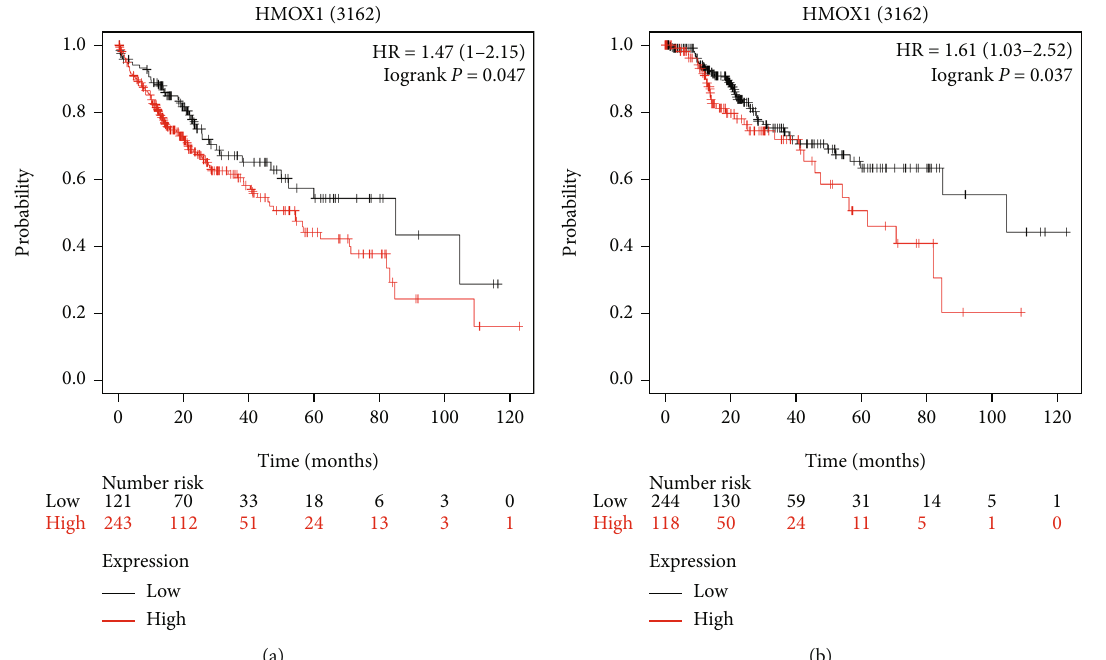
Figure 10: Actions of HMOX1 expression on OS and DSS of HCC patients. (a) Actions of HMOX1 expression on OS of HCC patients were examined by the KM-plotter. (b) Actions of HMOX1 expression on DSS of HCC patients were examined by the